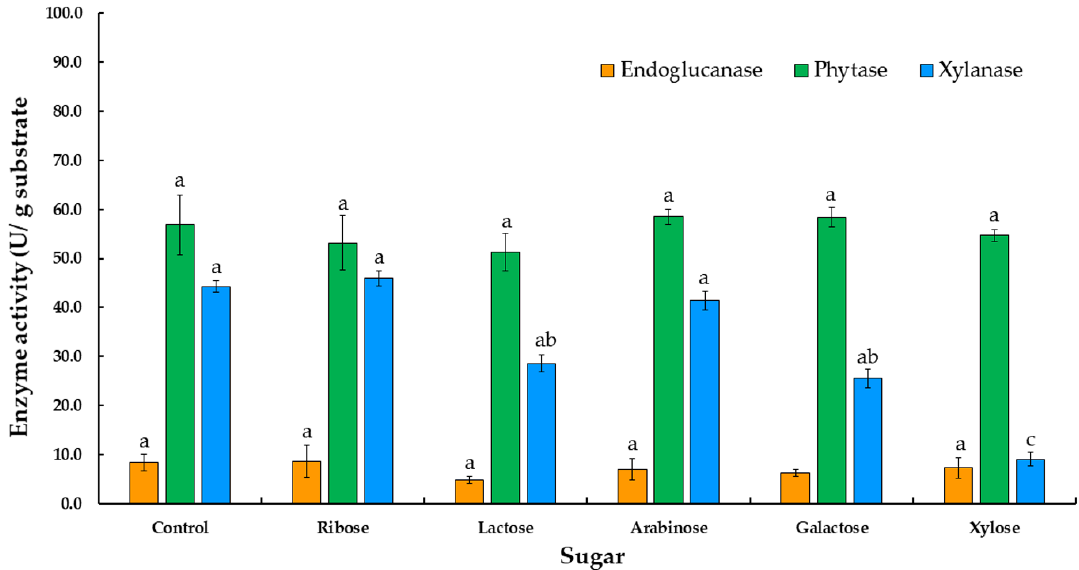
Figure 2. Phytase, endoglucanase, and xylanase production by Thermoascus aurantiacus SL16W with different sugars under semi-solid state fermentation. Average ± standard deviation from three replicate experiments. Different letters in the same column are considered significantly different according to Duncan’s multiple comparison test ( p ˂ 0.05).